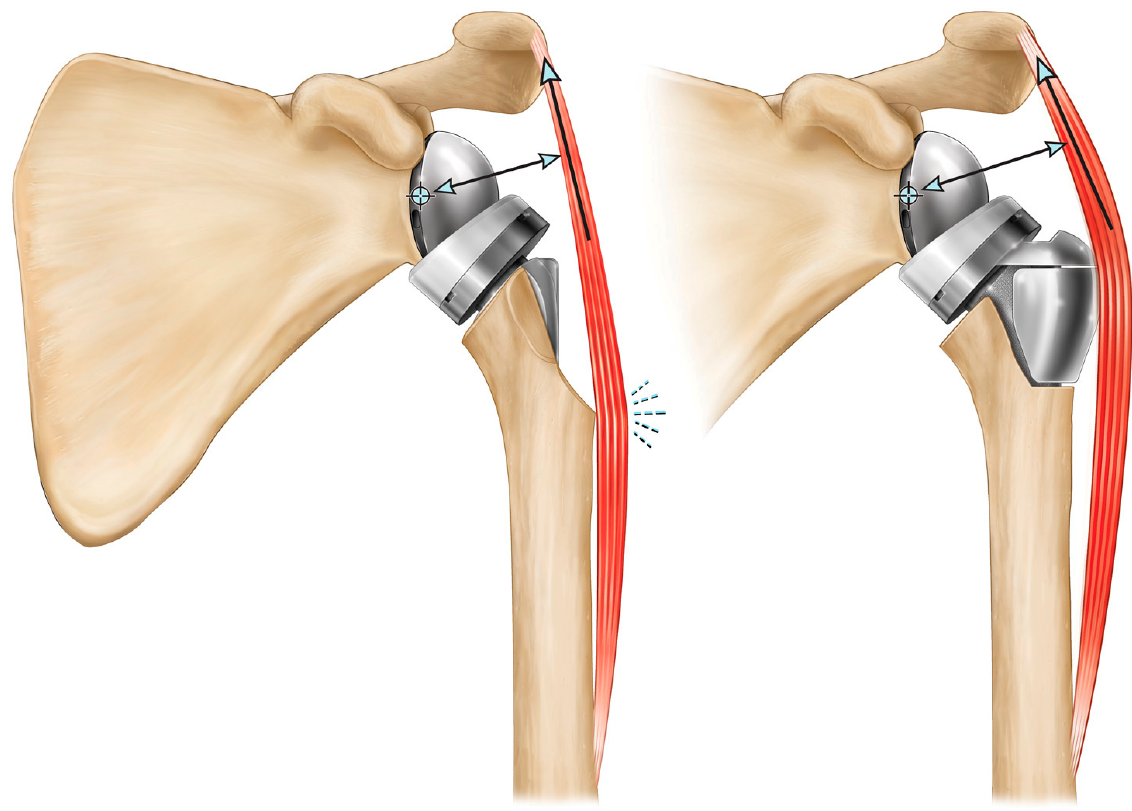
Figure 10. Use of an augmented humeral tray with rTSA in the case of proximal humeral bone loss to improve rTSA biomechanics by restoring the greater tuberosity shape and increasing deltoid wrapping to improve stability while increasing the deltoid moment arm to improve deltoid effi- ciency.